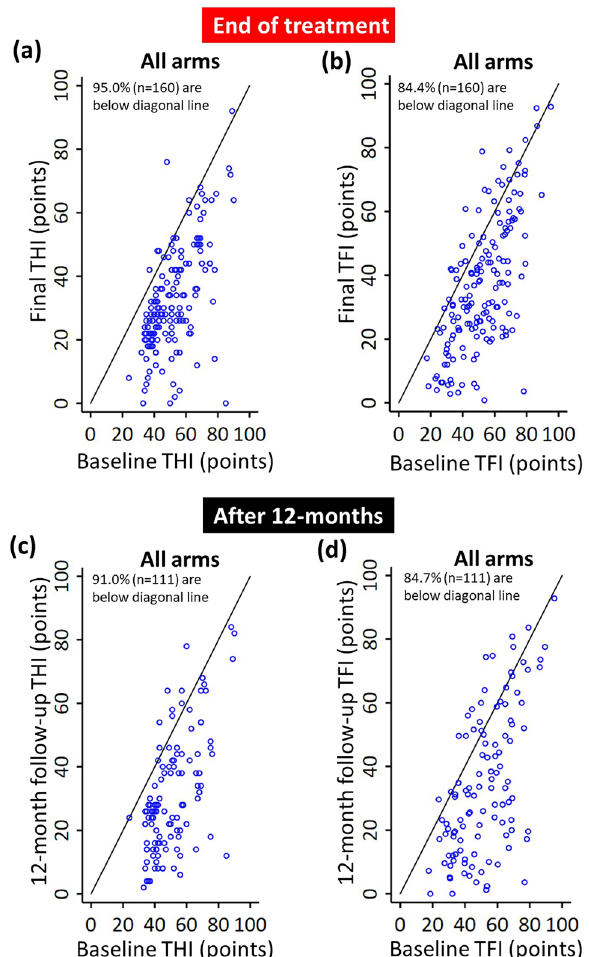
Figure 8. Long-term clinical efficacy of bimodal neuromodulation. ( a,b ) Scatter plots of THI or TFI scores are shown that include each treatment-compliant individual at baseline versus end of treatment (12-week final visit) for all arms pooled together to represent bimodal neuromodulation in general. ( c,d ) Scatter plots of THI or TFI scores are shown that include each treatment-compliant individual at baseline versus 12-month post-treatment visit for all arms pooled together. All individuals who completed at least the assessments displayed in each figure were included to maximize the total number of subjects plotted in each figure, leading to a large sample size for each plot. Compliance to treatment is defined as ≥ 36 h treatment at final. Data points are jittered for